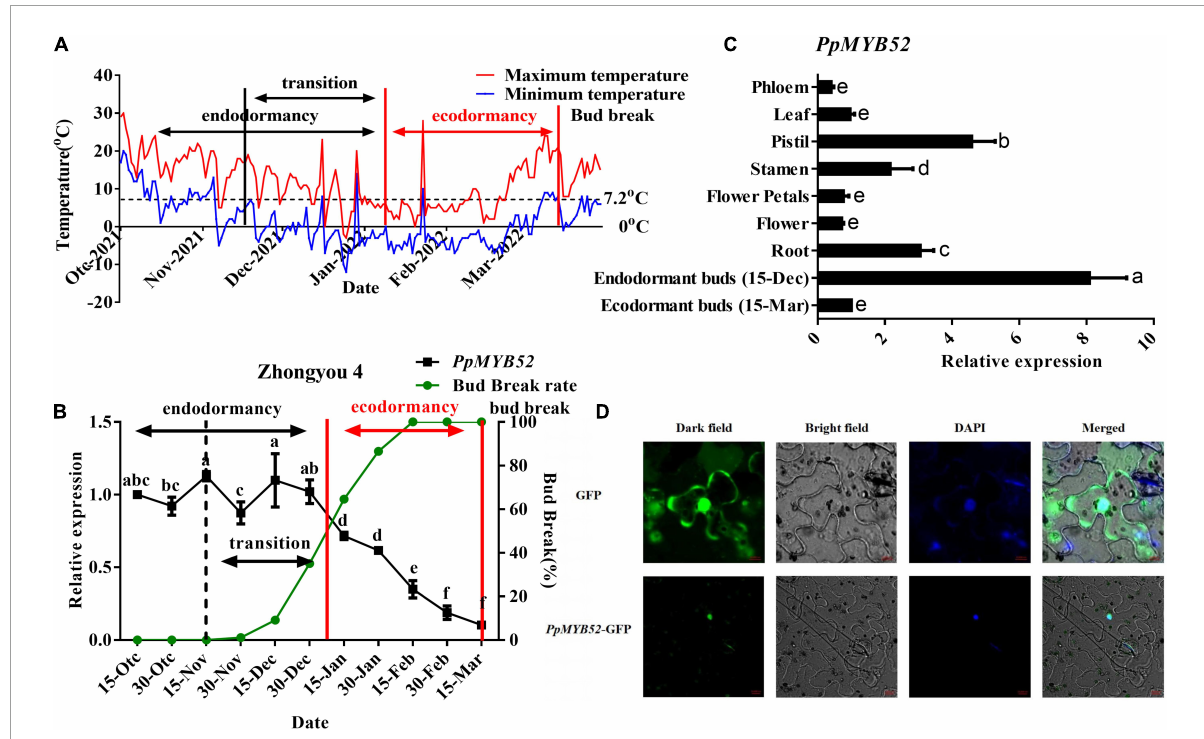
FIGURE2 Definition of the dormancy stages of Zhongyou 4 flower buds and expression patterns of PpMYB52 . (A) Daily maximum temperature and daily minimum temperature from October 2021 to March 2022. (B) Definition of the dormancy stages of Zhongyou 4 flower buds and expression level of PpMYB52 from 15 October 2021 to 15 March 2022. At each sampling time, 25 of the shoots were placed in tap water for 25 days. If less than 50% of the buds broke dormancy, the flower buds were considered to be in the endodormancy stage; the values are the means of 25 shoots. (C) Expression of PpMYB52 in different tissues of Zhongyou 4 peach. (D) Subcellular localization of PpMYB52 . PpMYB52 was fused to YFP for transient transformation into 4-week-old tobacco ( N. benthamiana ) leaves. 4’,6-Diamidino-2-phenylindole (DAPI) was used as a nuclear marker. The values represent the means ± SD of three replicates, and the different letters above the bars represent significant differences; P < 0.05.